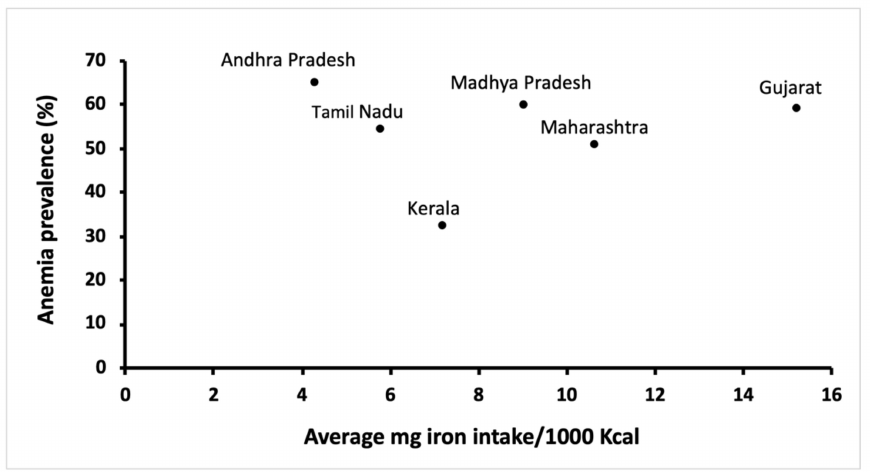
Figure 1. Iron consumption and anemia prevalence in rural women in six states of India [16,44]. To counterbalance low iron bioavailability, the U.S. Institute of Medicine (IOM) sug- gested that vegetarians should consume 80% more dietary iron [3]. Although in the right direction, this strategy might not be an immediately achievable solution with respect to India, where 89% of the population still consume an iron-deficient diet [45]. Due to a predominantly non-heme dietary pattern, poor iron bioavailability (50% lower) and Indian population characteristics, the ICMR has set higher levels of recommended dietary